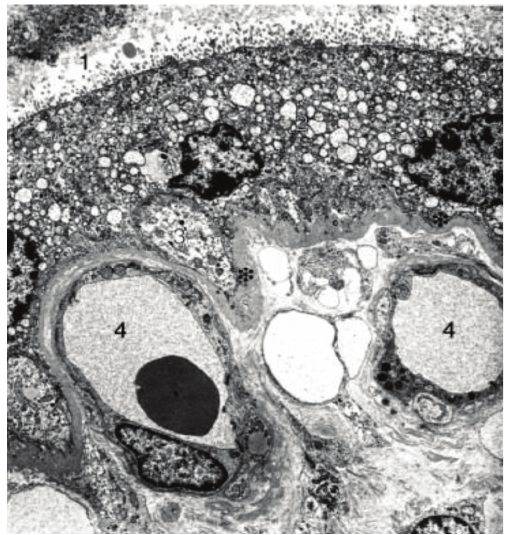
Figure 1: Electron micrograph of a chorionic villous human placenta. Picture depicts the intervillous space (1) and the placental barrier formed by the syncytiotrophoblast (2), a discontinuous cytotrophoblast (3), basal laminae (asterix), conective tissue, and fetal vessels